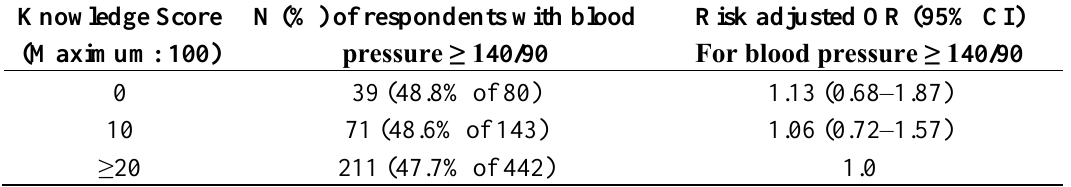
Table 6. Percentage and risk adjusted odds ratio (OR) * with its 95% confidence interval (95% CI) for systolic/diastolic blood pressure ≥ 140/90 among hypertensive